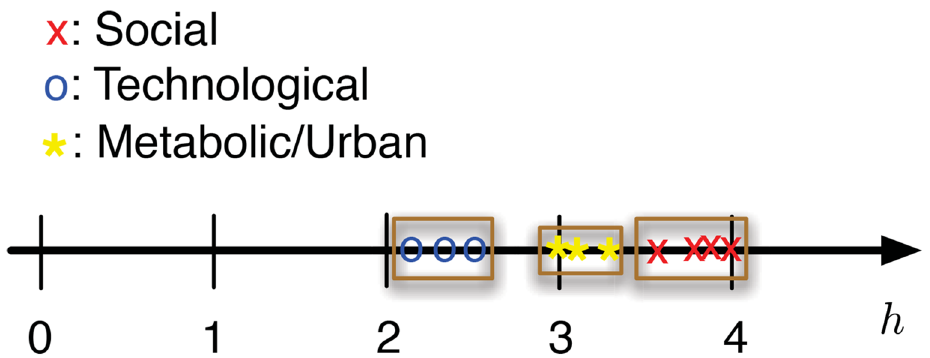
Fig 2. power-hop exponents of various types of networks. The power-hop exponent h of similar types of networks cluster well together. Interactions within a city have been described through biological metaphors and hence, it is logical that the exponents of our urban network datasets is close to that of the biological networks.